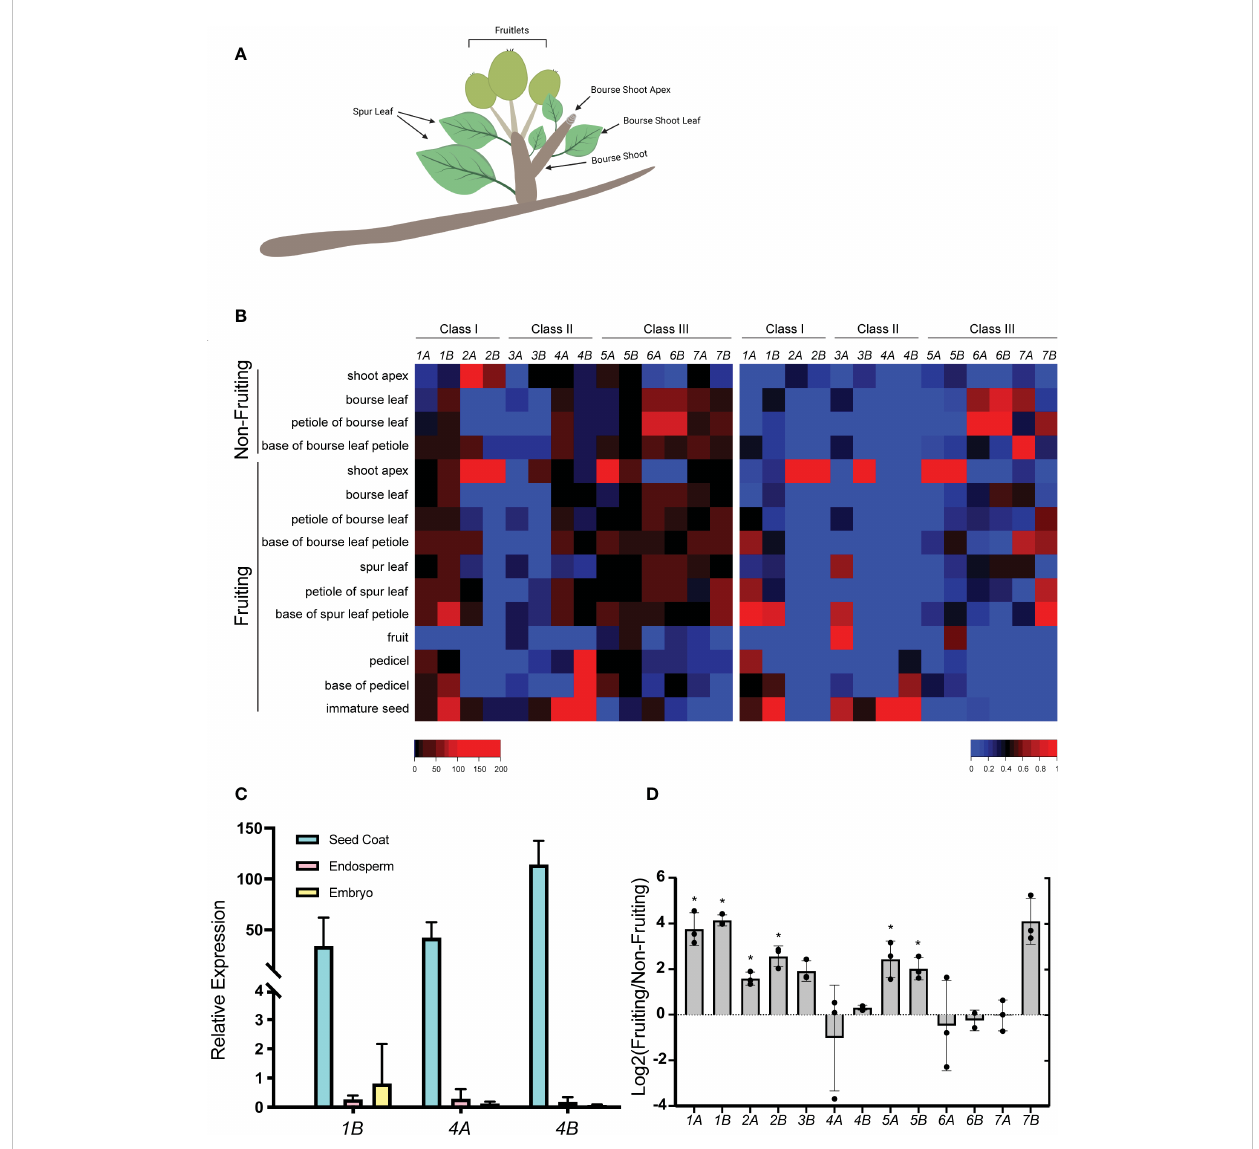
FIGURE 4 Expression pro fi les of MdGA2ox genes in spur and seed structures. (A) . Illustration of a fruiting apple spur at the time of analysis. (B) . Expression of MdGA2ox genes in structures dissected from non-fruiting or fruiting spurs. The heat map on the left represents expression values derived from quantitative PCR and relative to an apple ACTIN gene. The heat map on the right represents expression values relative to the strongest expression for each gene among structures. Color keys at the bottom indicate expression levels from low/least (blue) to high/greatest (red). (C) . Relative expression of MdGA2ox1B , -4A , and -4B in the seed coat, endosperm, and embryo of the developing seed. (D) . Relative MdGA2ox expression in fruiting and non-fruiting shoot apex. Log 2 (Fruiting/Non-fruiting) represents the fold difference of relative expression in the shoot apex of fruiting spurs versus that of non-fruiting spurs. Black dots indicate individual values of three biological replicates, and error bars represent standard deviation among replicates. Asterisks indicate statistical signi fi cance (t-test, p <